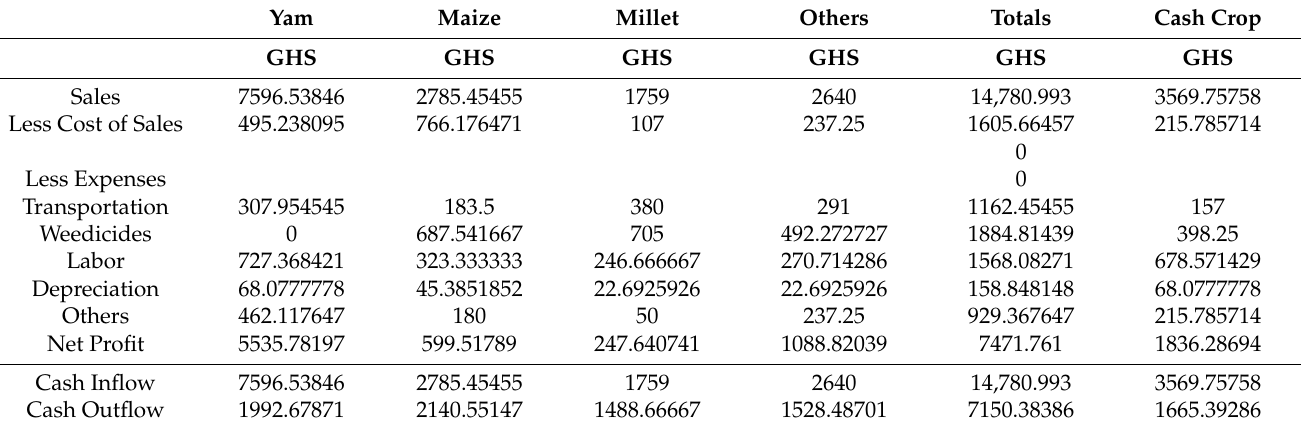
Table A2. Profit and loss of various staple and cash crops in the Bono-East Region of Ghana.